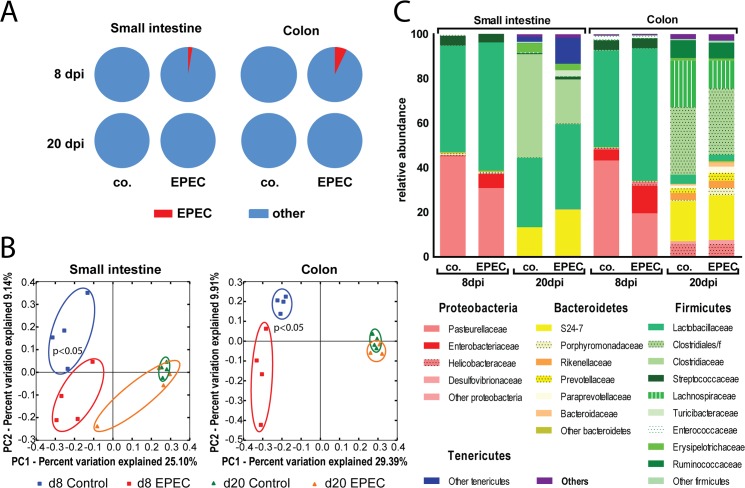
EPEC infection temporally alters the composition of the enteric microbiota.Bacterial DNA was extracted from the small intestine and colon of newborn mice infected with WT EPEC at 8 and 20 days p.i. or untreated age-matched control animals and analyzed by 16S rDNA sequencing. (A) Relative abundance of the OTU 4425571 (Enterobacteriaceae, representing EPEC in red) in infected and uninfected animals. (B) PC1/PC2 plot illustrating the similarity of the microbiota within the different groups in the small intestine (left) and in the colon (right) (d8 uninfected, blue squares; d8 EPEC-infected, red squares; d20 uninfected, green triangles; d20 EPEC-infected, orange triangles). (C) Phylum level composition of the 8 different groups. Proteobacteria are represented in different shades of red, Bacteroides in different shades of yellow, Firmicutes in different shades of green and Tenericutes in blue.